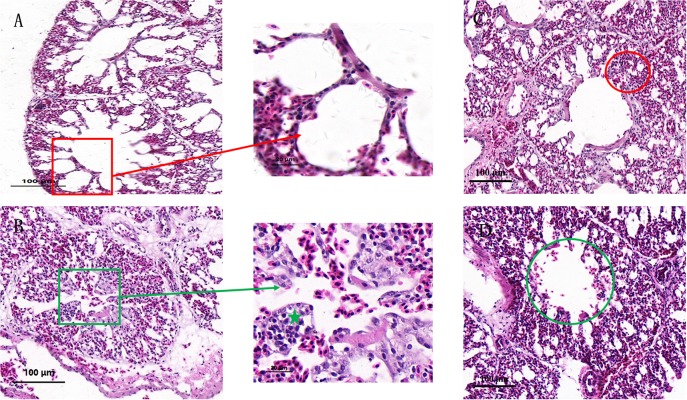
Effects of co-infection on the histology of chicken lung. Paraffin sections of tracheal tissues from the control group (A), co-infection group (B), MG group (C), and E. coli group (D), stained with hematoxylin-eosin (100×). (A) Red frame shows normal bronchioles and alveolar structures. (B) Green frame shows bronchial epithelial adhesions, epithelial cells degeneration, necrosis. Green star illustrates lymphocyte infiltrations around the bronchi. (C) Red circle shows intersomese hyperplasia in the MG group. (D) Green circle indicates slight bleeding in the tube cavity.